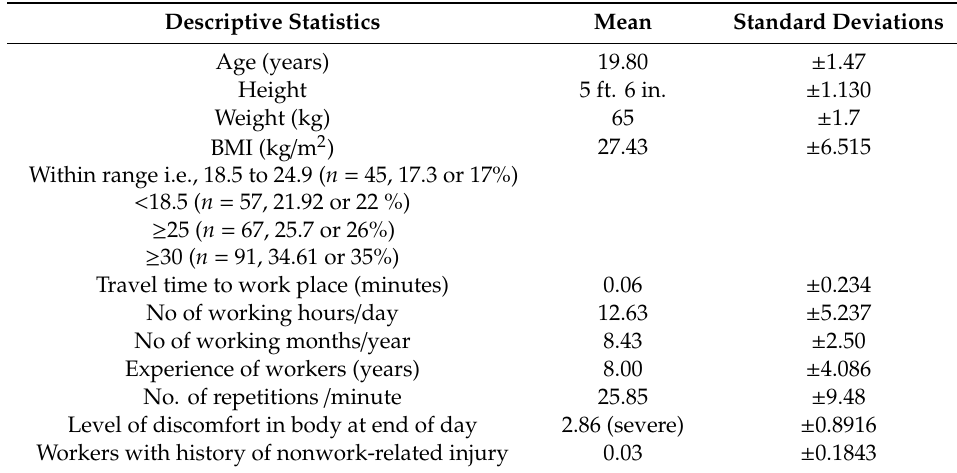
Table 1. Summary of personal and occupational factors of workers.